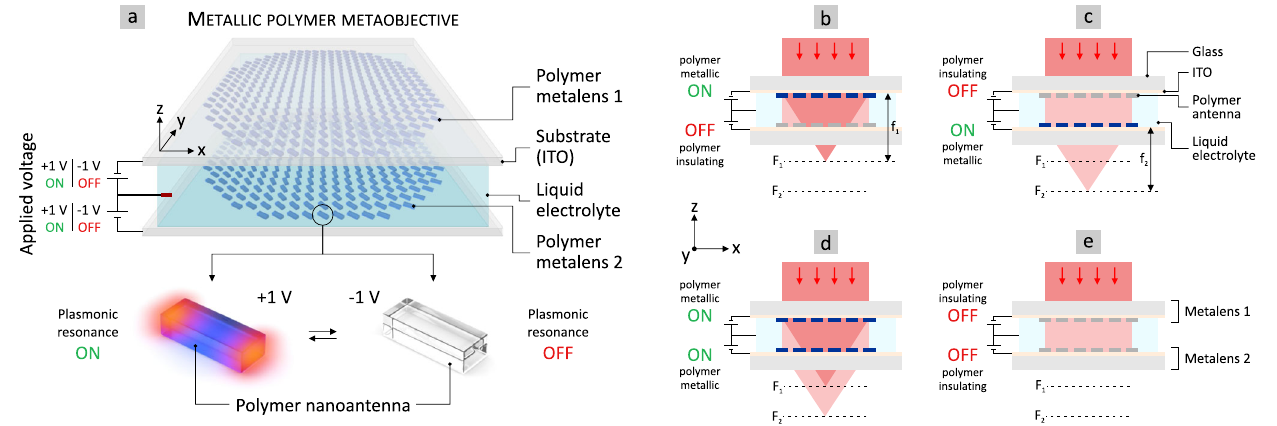
respectively. Bottom: The electrical switching is based on a reversible metal-to- insulator transition of the metallic polymer. A voltage of +1V turns polymer nanoantennasmetallicandtheirplasmonicresonanceON.Avoltageof − 1Vswitches the polymer nanoantennas into an insulating state and their plasmonic resonance OFF. b – e Depending on the individual voltage applied to the polymer metalenses, four different states become possible. b (metalens 1: ON, metalens 2: OFF): focus at